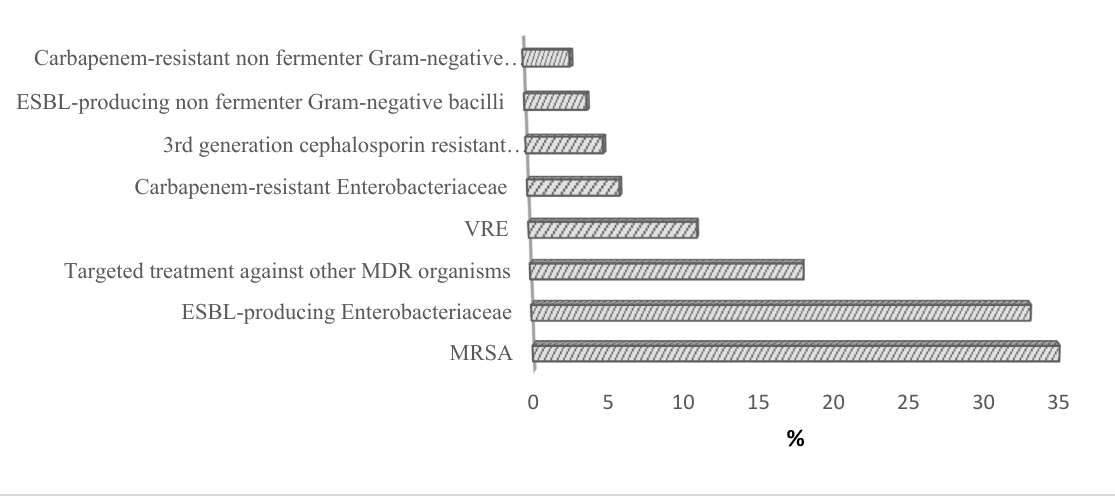
Figure 1. Common pathogens reported in hospitals.